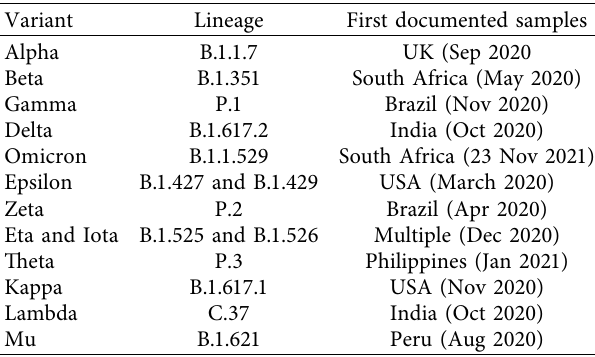
Figure 2: Safety precautions used to avoid COVID-19 new variants infection. Table 2: SARS-CoV-2 new variants and its